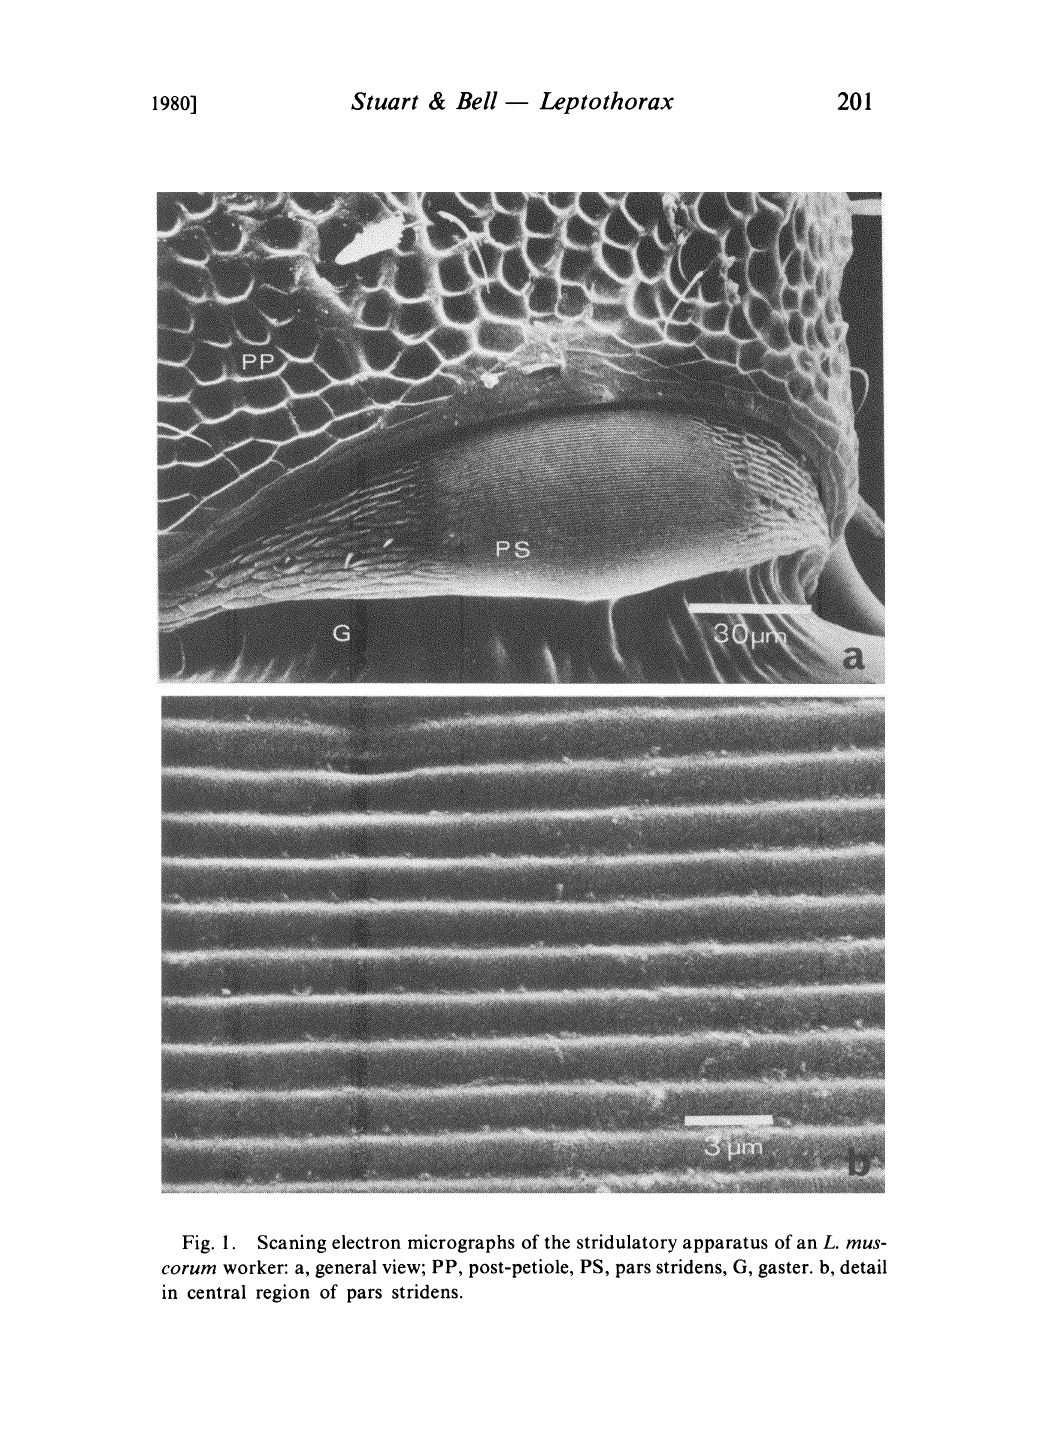
Fig. 1. Scaning electron micrographs of the stridulatory apparatus of an L. mus- corum worker: a, general view; PP, post-petiole, PS, pars stridens, G, gaster, b, detail in central region of pars